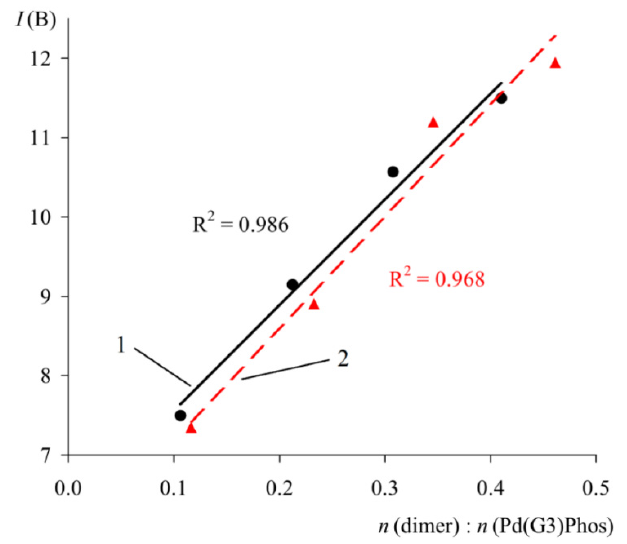
Figure 15. Plot of I B versus molar ratio of 1 to XPhos Pd G3 (1) and RuPhos Pd G3 (2). C (PdG3(Phos)) = 40 mmol/L.